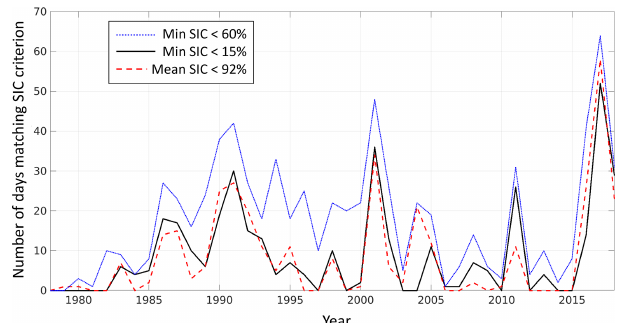
Figure 2. For each year of the sea ice time series (1978–2018), the number of days between 1 July and 31 October with a polynya ac- cording to the three most common criteria in the literature: black, minimum sea ice concentration (SIC) lower than 15% (e.g. Glo- ersen et al., 1992); blue, minimum sea ice concentration lower than 60% (Campbell et al., 2019); red, average sea ice concentration over the (fixed) polynya-prone region lower than 92% (after Gor- don et al., 2007).